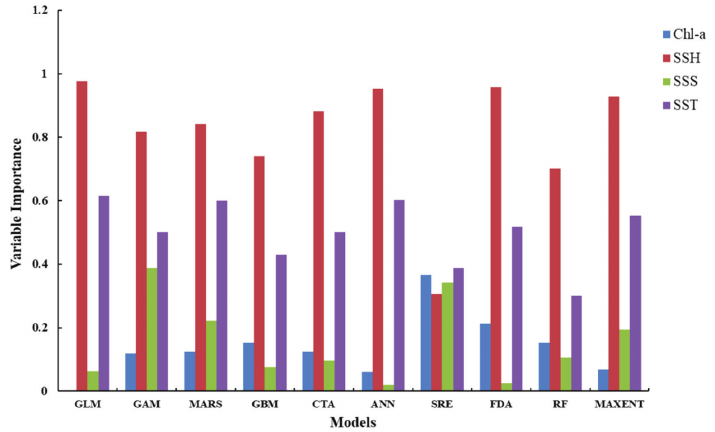
Figure 2. Relative environmental variable importance derived from the single-algorithm models.